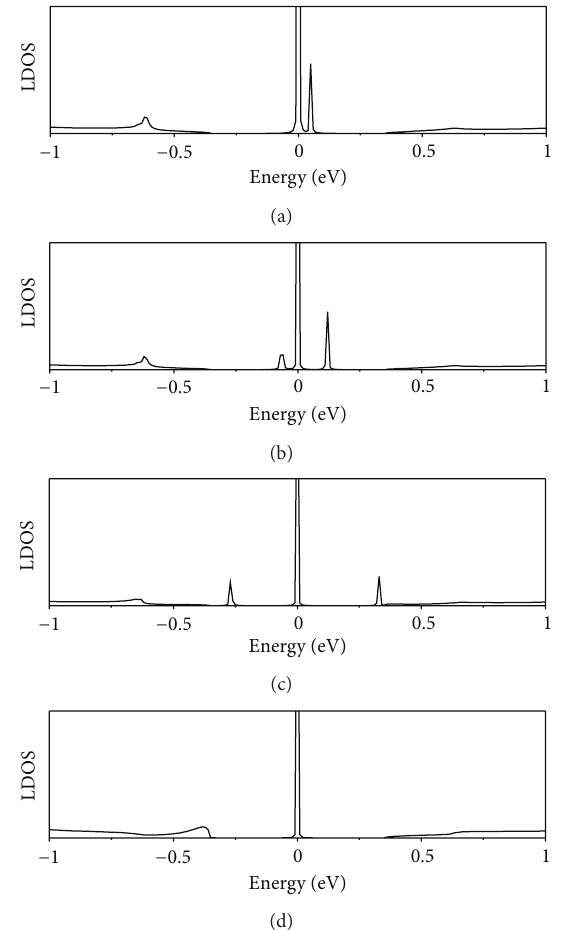
Figure 5: LDOS evaluated at the wedge region for the single (8,0)/(14,0) junction with a pair of pentagons ( 2 × 5 ) at the kneecap and varying strengths of the hopping ̃𝑡 parameter connecting the 8R octagon into the V8R void. The hopping parameter varies as 0, 0.1 𝑡 , 0.4 𝑡 and 𝑡 from top to